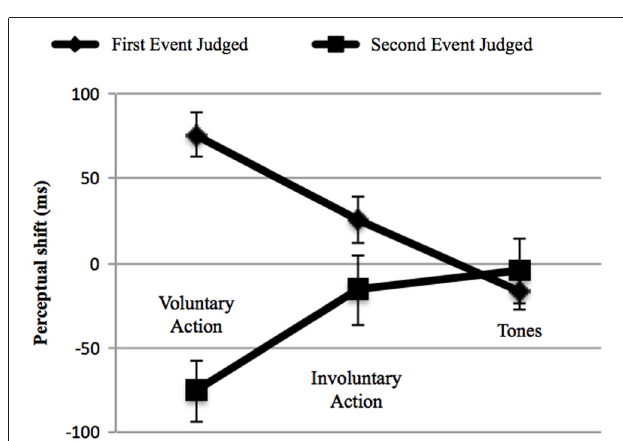
FIGURE 3 | (A) Differences in the mJE of Voluntary Action in BC vs . EC in the young adult group. Error bars represent SEM and * indicates the significantly difference between BC and EC ( p < 0.05). Here participants perceived the onset time of voluntary action later when it was followed by the tone (Voluntary Action in EC), as compared to the BC in which only the action was presented (Voluntary Action in BC). (B)